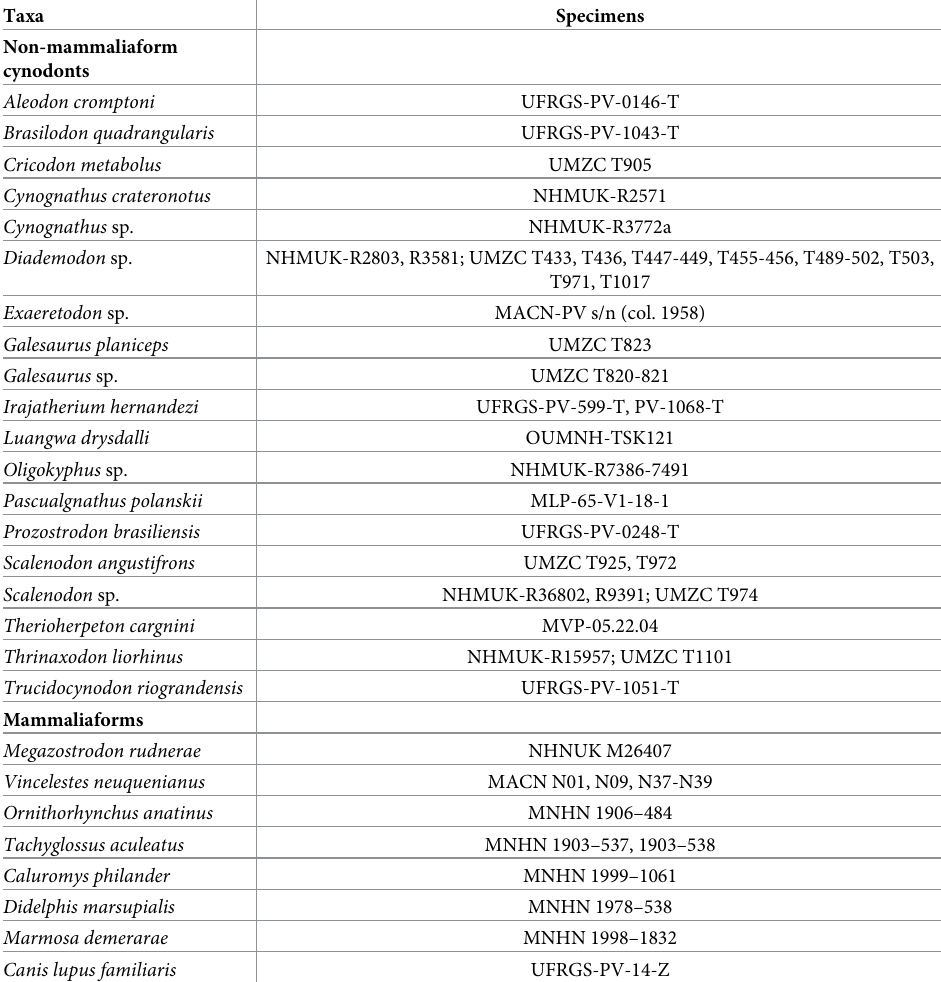
Table 1. List of specimens used for